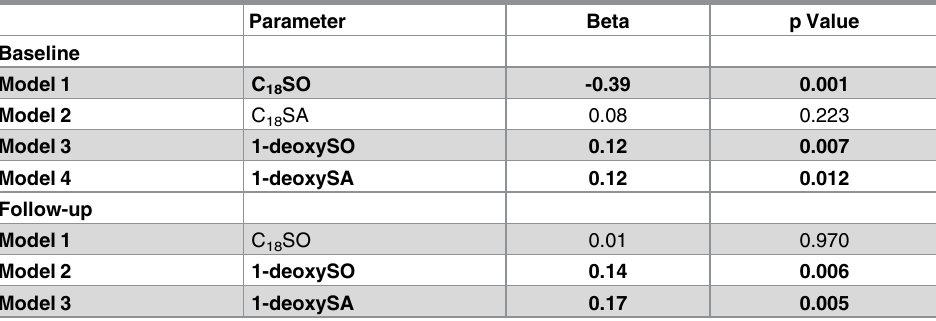
Table 2. Multiple linear regression models of HOMA_IR at baseline and